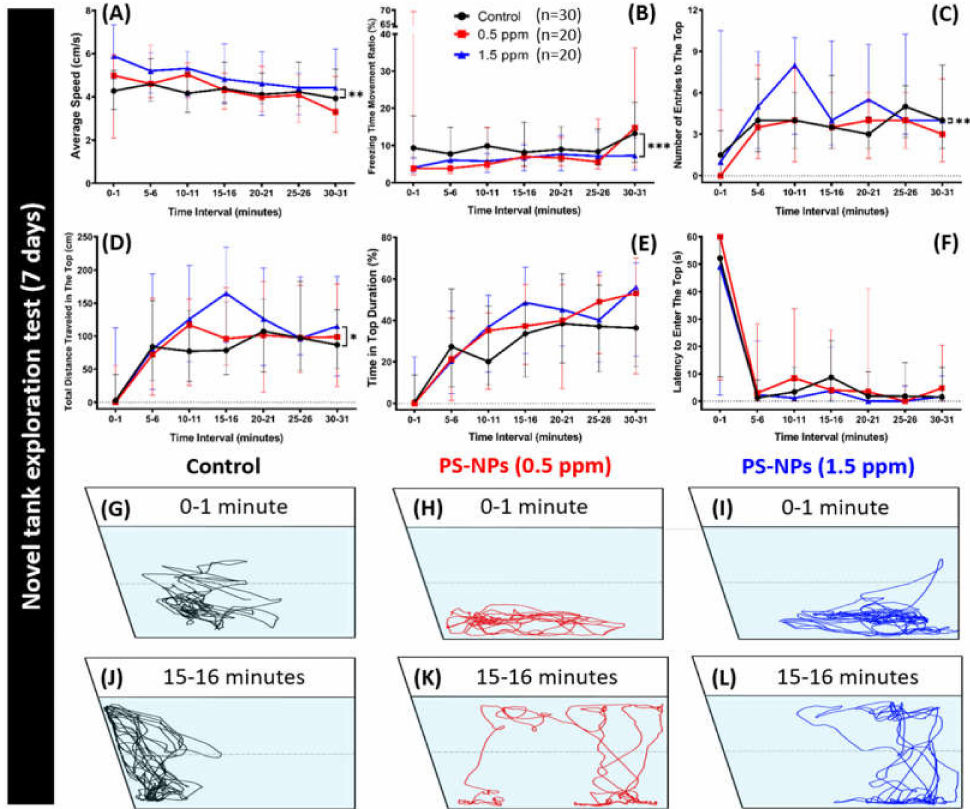
Figure 2. Novel tank behavior endpoints comparisons between control and polystyrene nanoplastics (PS-NPs)-exposed zebrafish groups after a ~7-day exposure. ( A ) Average speed, ( B ) freezing time movement ratio, ( C ) number of entries to the top, ( D ) total distance traveled in the top, ( E ) time in top duration, and ( F ) latency to enter the top were analyzed. The 1 min. locomotion trajectories for the control, 0.5 and 1.5 ppm PS-NPs exposed fish in the novel tank test were presented in ( G to L ), respectively. The black line represents the control group, the red line represents the low concentration PS-NPs group (0.5 ppm), and the blue line represents the high concentration PS-NPs group (1.5 ppm). The data are expressed as the median with interquartile range and were analyzed by a Kruskal–Wallis test, which continued with Dunn’s multiple comparisons test as a follow-up test ( n = 30 for control; n = 20 for each PS-NPs-exposed group; * p < 0.05, ** p < 0.01, *** p <